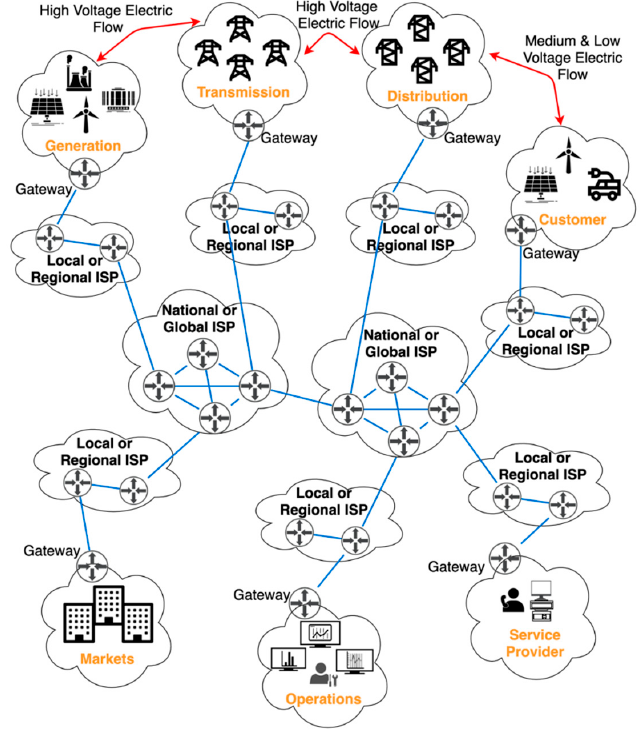
Figure 2. Smart Grid architecture and supporting Internet network infrastructure.